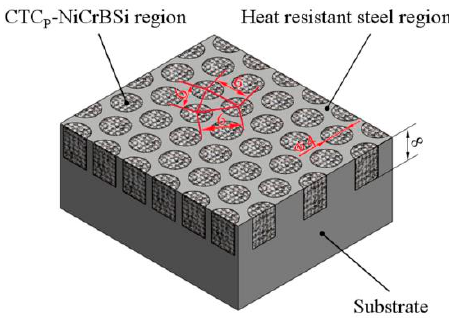
Figure 1. Schematic diagram of the CTC P -NiCrBSi/heat resistant steel composite layer (Dimensions are in mm).